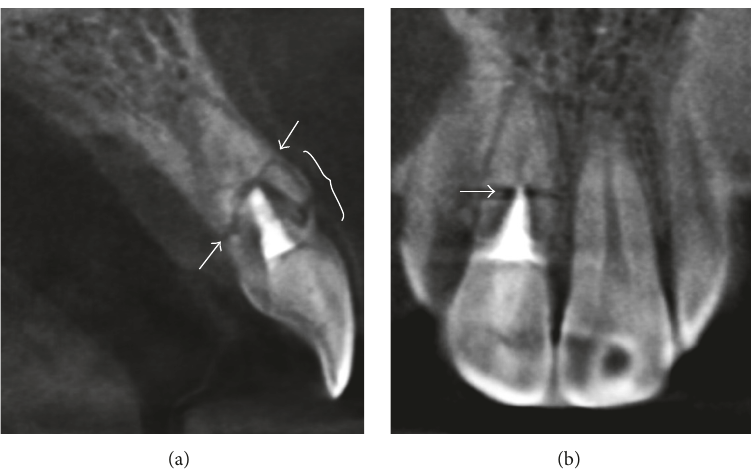
Figure 4: CBCT images (June 2015). (a) The sagittal CBCT slice of tooth 11 reveals a comminuted fracture on the labial aspect within the cervical third of the root (brace). A complete fracture line was found running obliquely from the middle third on the facial aspect through the cervical third on the palatal aspect (arrows). (b) The coronal CBCT slice reveals a horizontal root fracture in the middle third of the root without interposition of hard tissue